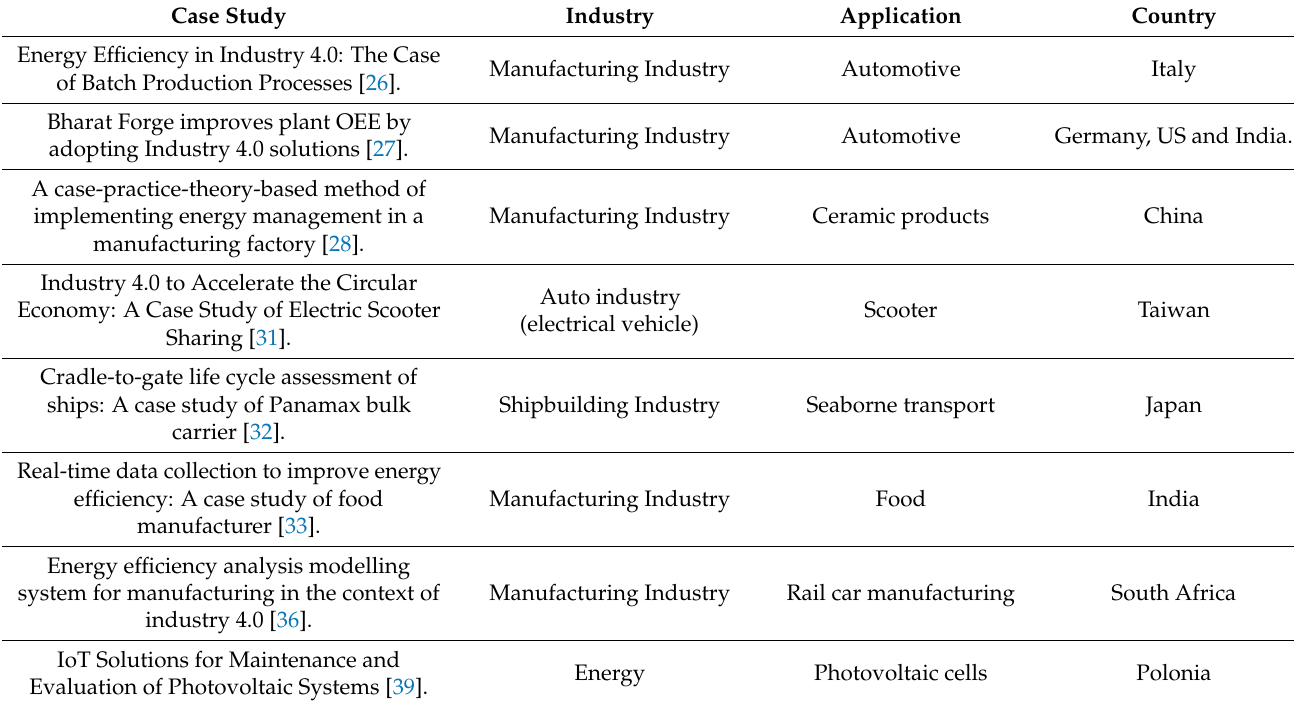
Table 1. Summary and information of case study: environmental